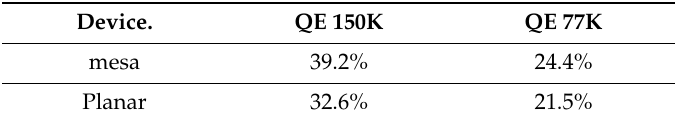
Table 1. Comparison of the QE of the planar and mesa-isolated type-II superlattice (T2SL) devices at 150 and 77 K at λ = 3.8 µm and at the applied bias of +40 mV.